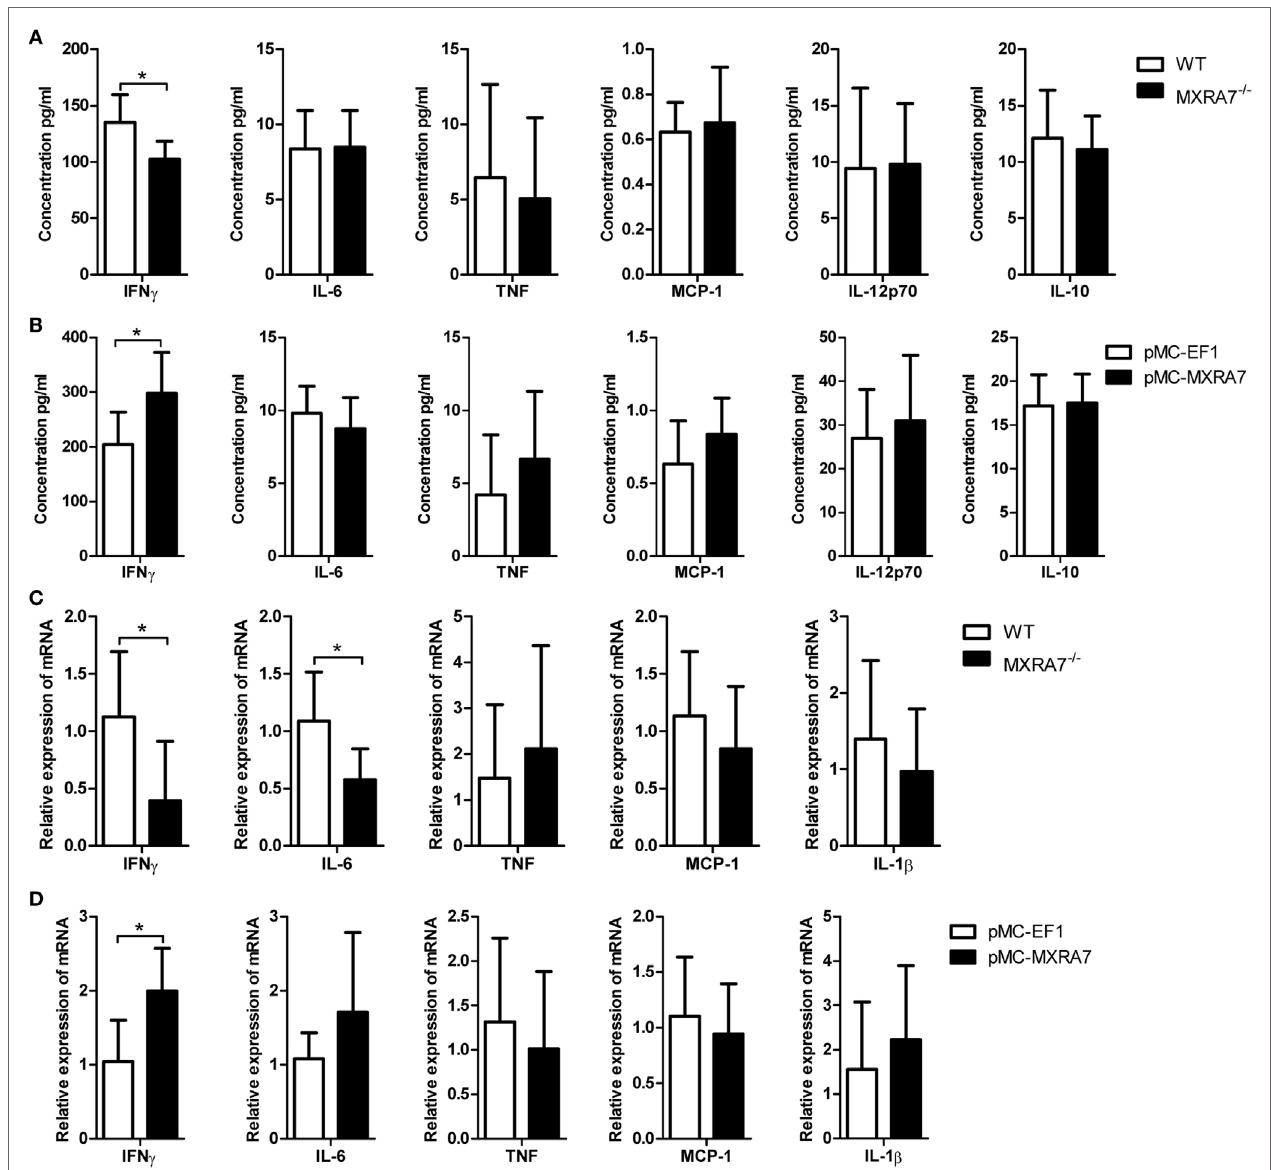
FigUre 5 | Matrix remodeling associated 7 (MXRA7) deficiency inhibits and MXRA7 overexpression promotes the expression of pro-inflammatory cytokines. (a,B) Serum was collected from different groups of mice 24 h after 1 ml/kg CCl 4 injection. Serum IFN γ , IL-6, TNF, MCP-1, IL-12p70, and IL-10 were determined using cytometric bead array mouse inflammation kit. (c,D) Livers were isolated from different groups of mice 24 h after 1 ml/kg CCl 4 injection. Expression of IFN γ , IL-6, TNF, MCP-1, and IL-1 β mRNAs in livers was detected by reverse transcription-quantitative real-time PCR. Data are presented as the summary of three experiments. * p <